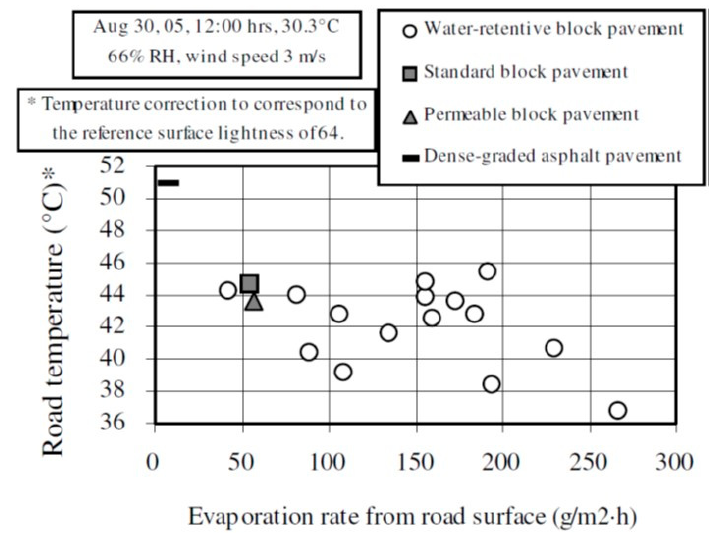
18 Figure 11. Thermal evolution of concrete at midnight, ( a ) temperature evolution, and ( b ) release of